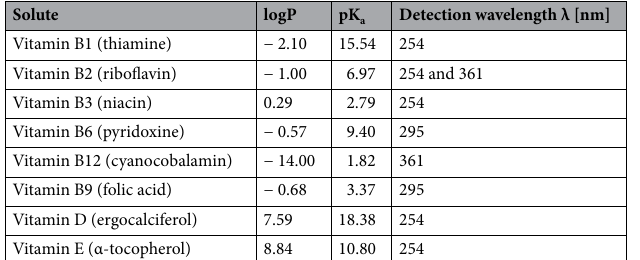
Table 3. Some physicochemical properties of the investigated vitamins (theoretical values of pK a were found in Drug-bank).